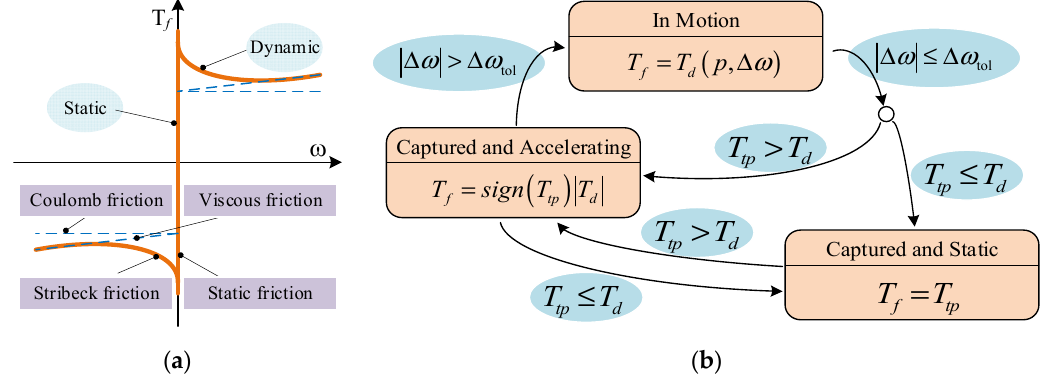
Figure 2. Stribeck friction model ( a ) and clutch friction working modes switching according to di ff erent transmitted torques and relative speeds of clutch ( b ).